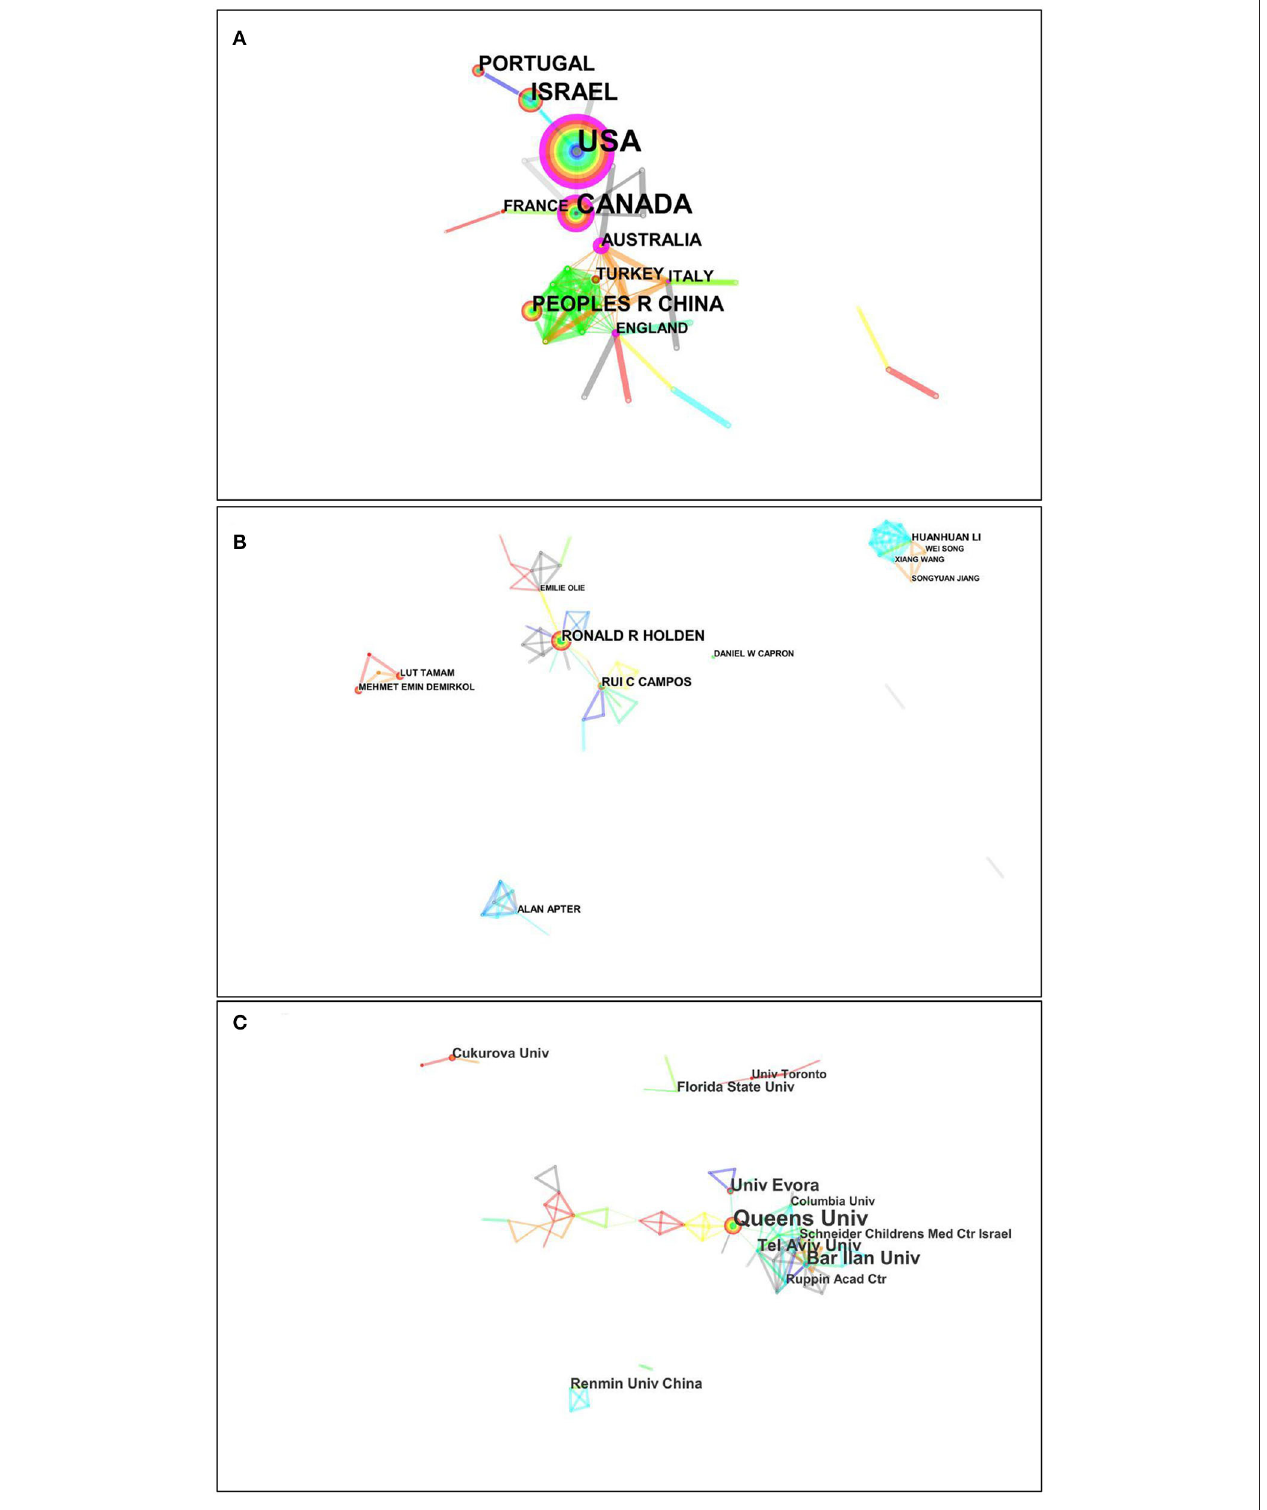
FIGURE 3 | Visualization map of the scientific collaboration network analysis of psychache research in the suicidology field from 1994 to 2020. Collaboration among countries (A) , authors (B) , and institutions (C) .